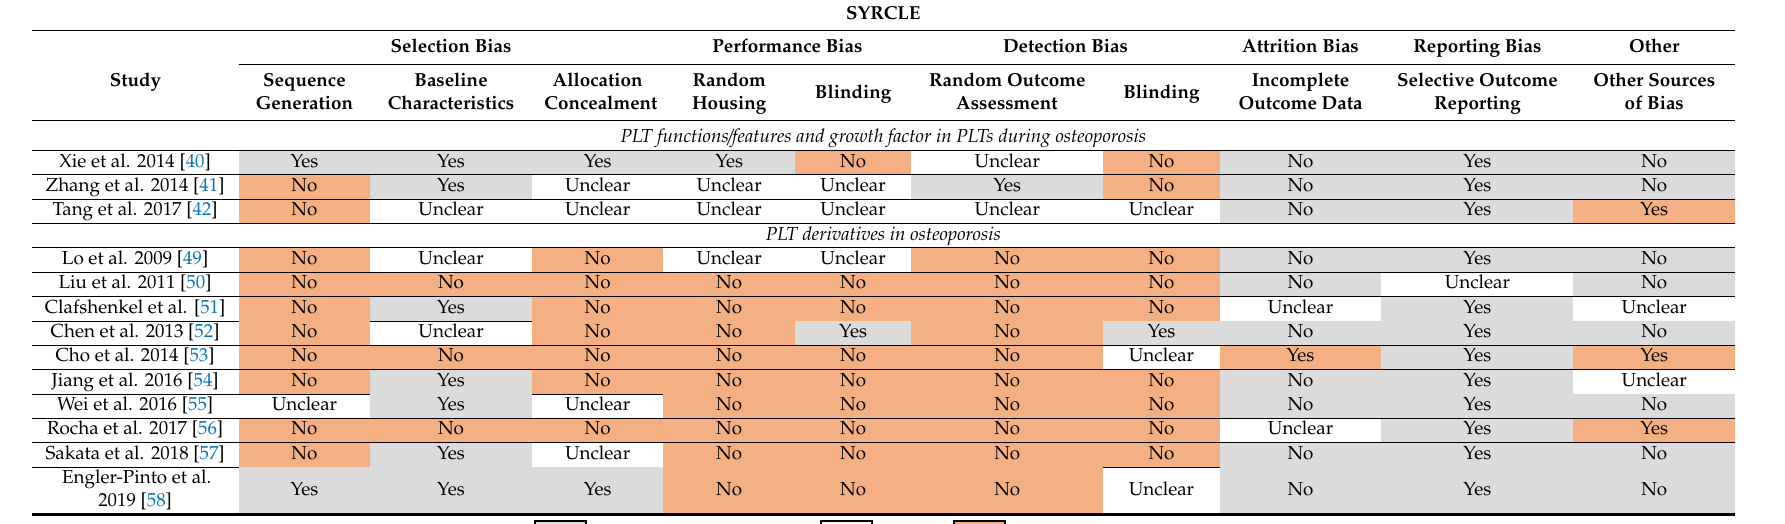
Table 5. SYRCLE’s tool for assessing risk of bias in the in vivo